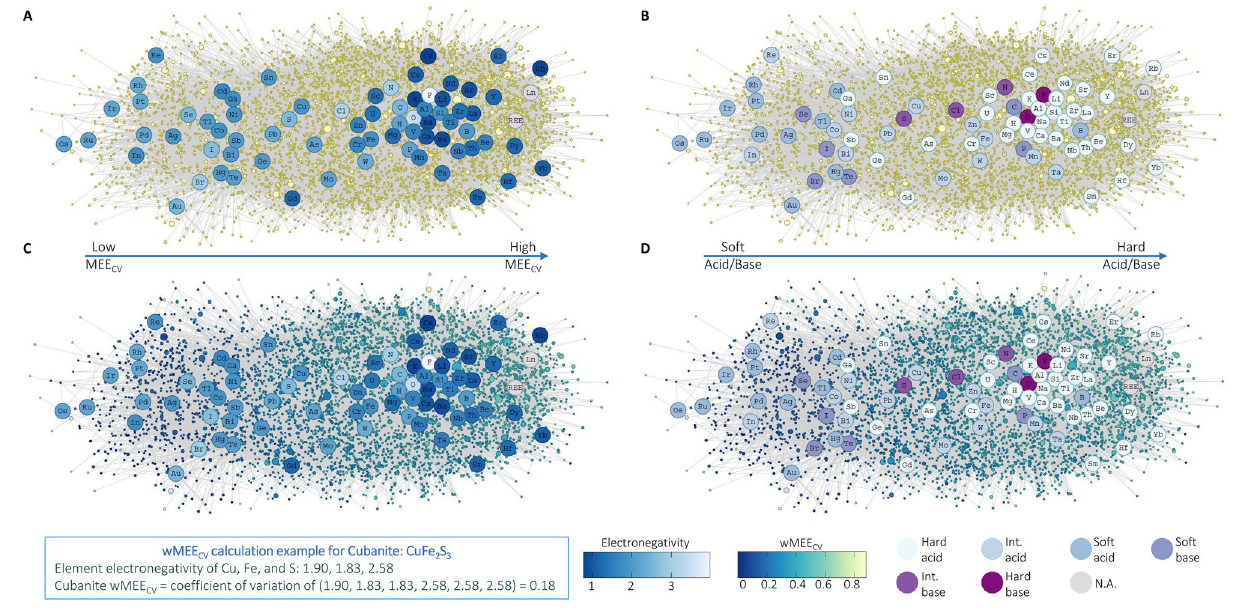
Figure 1. Electronegativity and HSAB dynamics in the full mineral chemistry network. ( A ) Bipartite mineral chemistry network containing all known minerals and their constituent elements. Mineral nodes are represented by small yellow circles, and element nodes are represented by blue scale circles with each element’s chemical symbol. Element nodes are colored by Pauling scale electronegativity 3 . Network lines (“edges”) connect minerals to all of their constituent elements (ex: cubanite—CuFe 2 S 3 node has network edges connected to Cu, Fe and S). Mineral nodes are sized by the number of known localities. Minerals > 4.33 Ga represent meteorite, asteroid, or pre-solar sources. Node position of the default network layout configuration uses the force-directed Fruchterman-Reingold algorithm 52 . ( B ) The same network as Fig. 1A with element nodes colored by Hard Soft Acid Base theory classification 4 . ( C ) The same network as 1A with minerals colored by weighted Mineral Element Electronegativity Coefficient of Variation (wMEE CV ). wMEE CV example calculation is shown for the mineral Cubanite